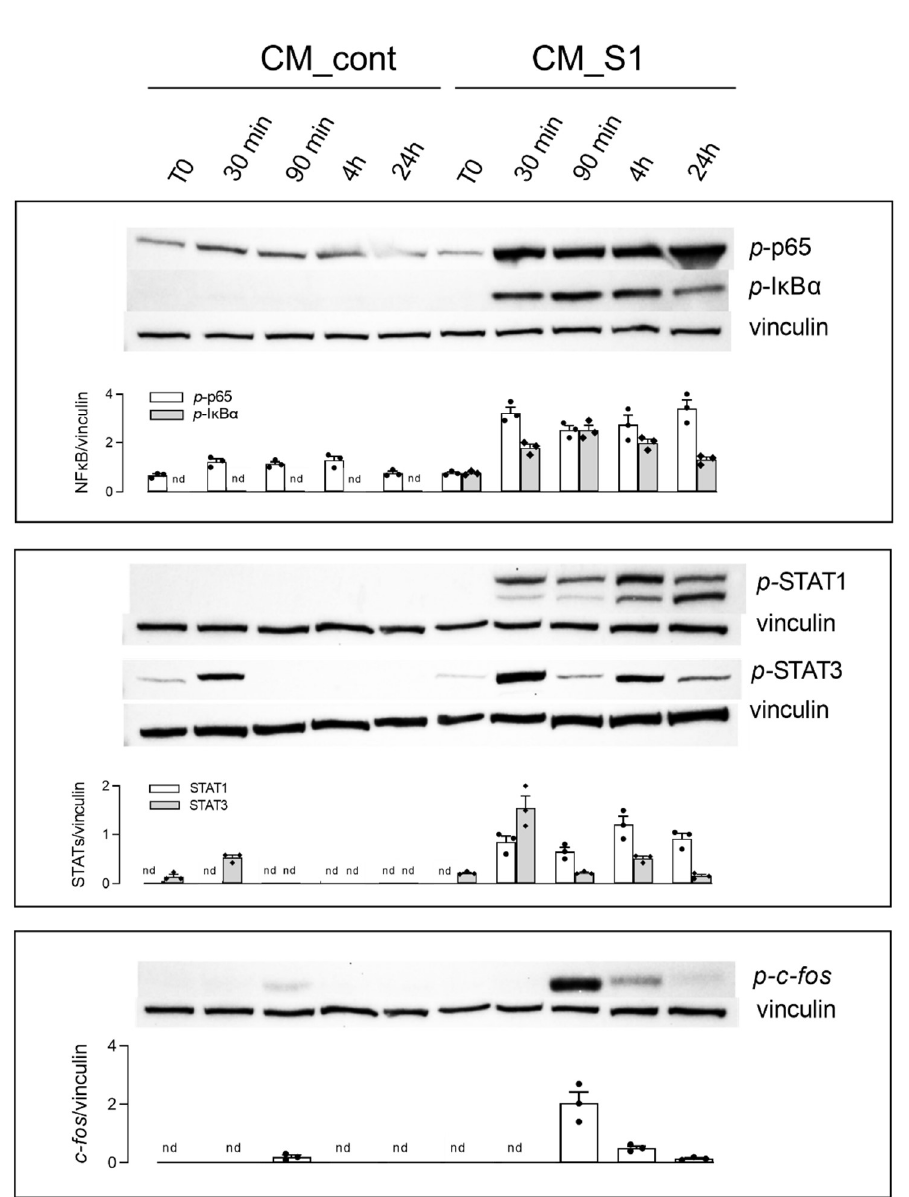
Figure 3. A549 were incubated for the indicated times with conditioned medium (CM) from un- treated (CM_cont) or S1-treated (CM_S1) monocyte-derived macrophages (MDM). The expression of the indicated proteins was assessed by means of Western Blot analysis, as detailed in Methods; representative blots are shown and the densitometric analysis of three different experiments is shown.